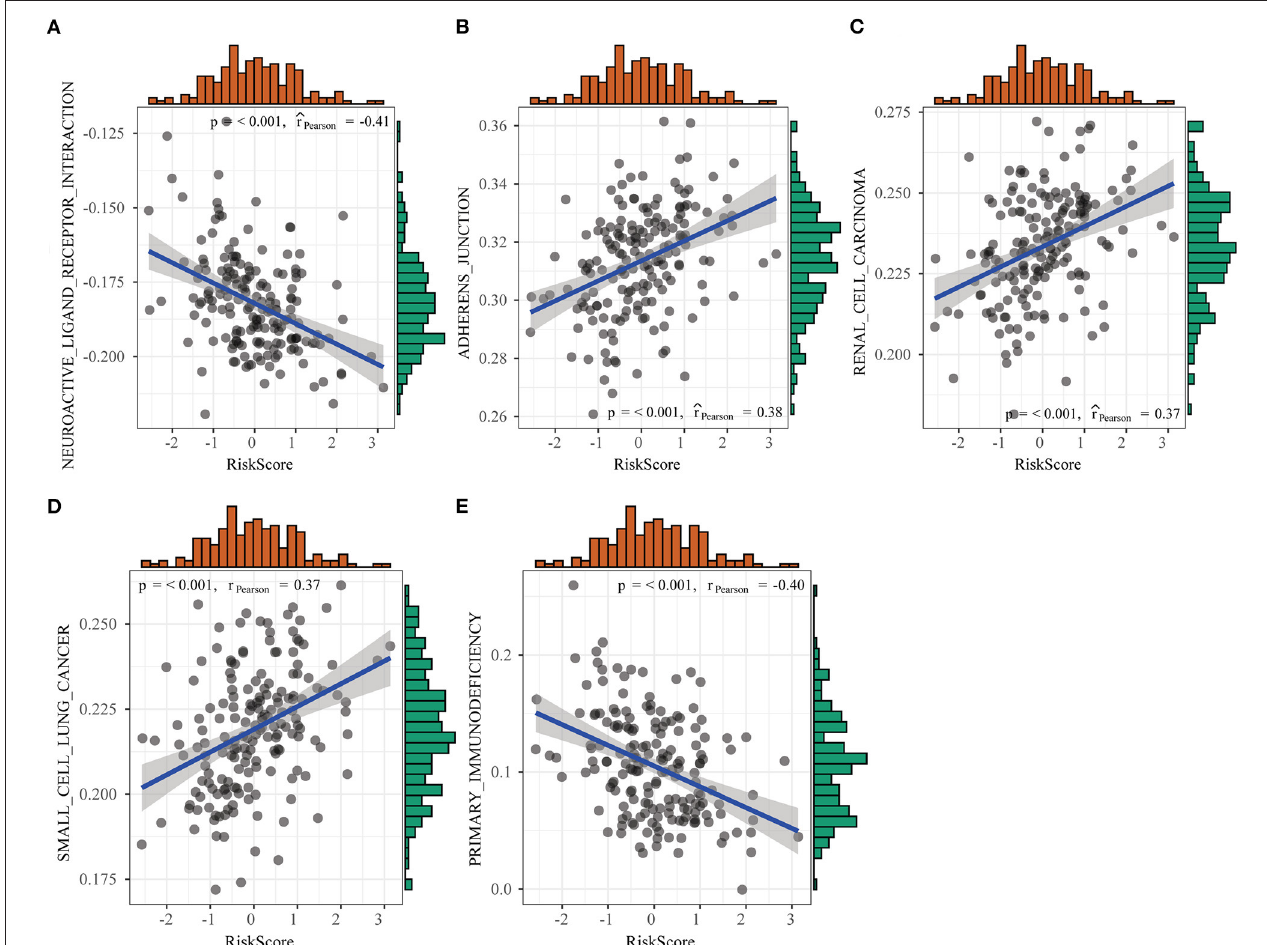
FIGURE 10 | Differences in pathways enriched between high- and low-risk groups detected by gene set enrichment analysis